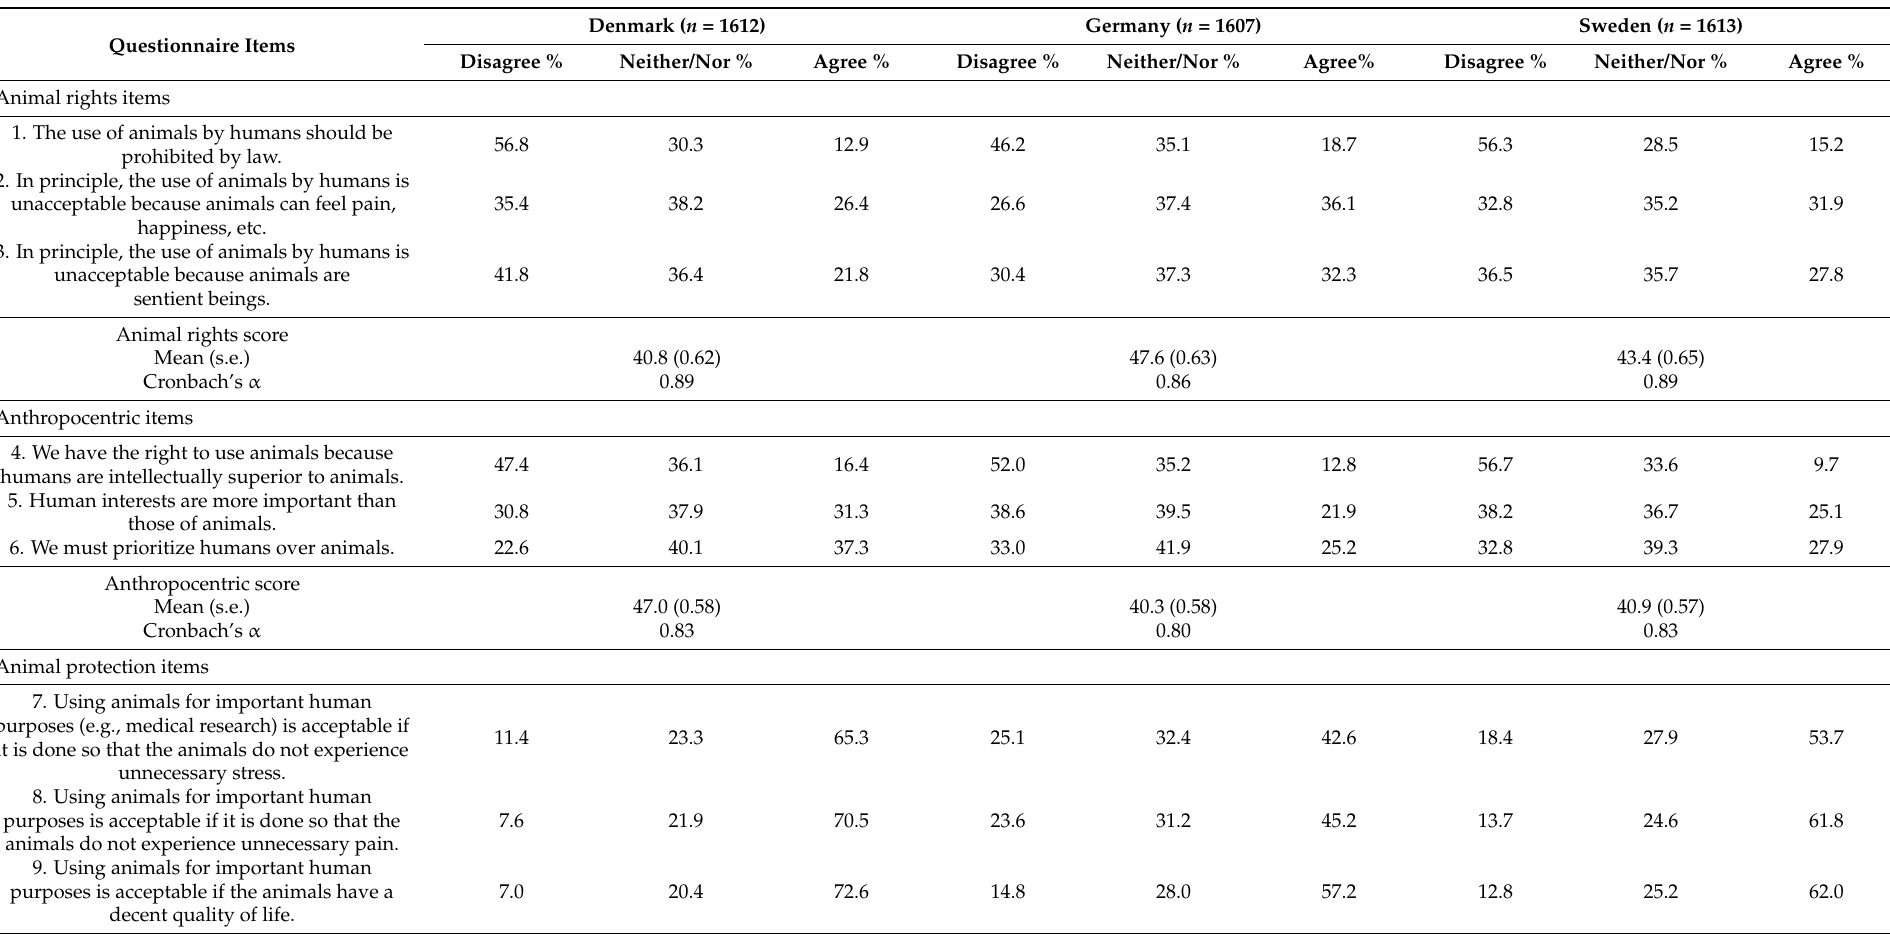
Table 2. Scores for the four animal ethics scales and share (reported in percent) of consumers that disagree/agree with the specific statements relating to the four orientations in Denmark, Germany, and